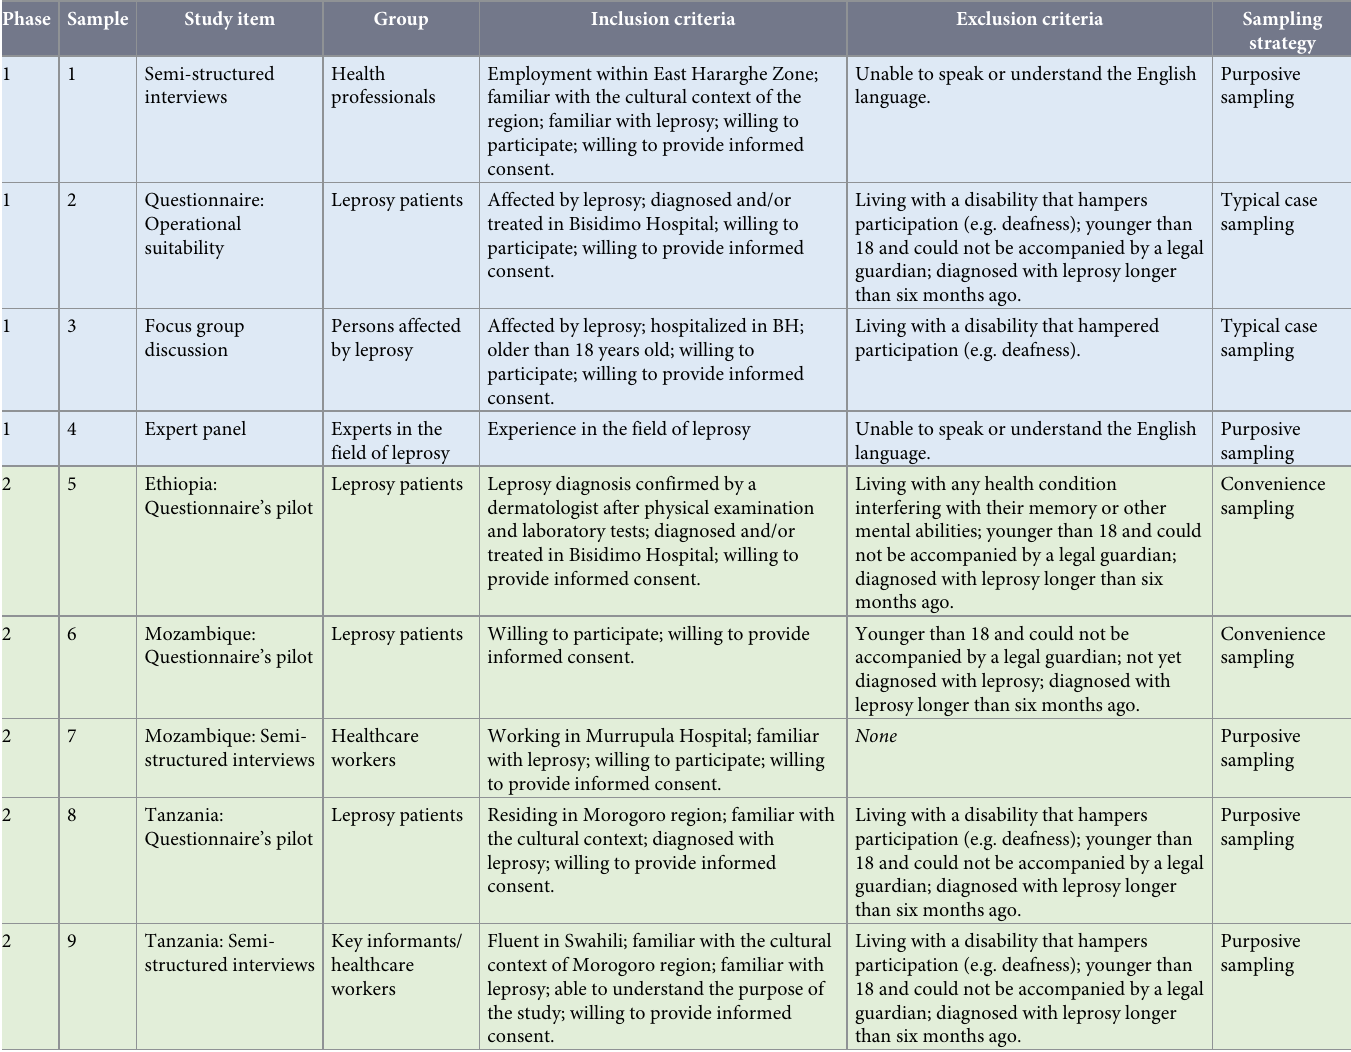
Table 1. In-, exclusion criteria and sampling strategy per